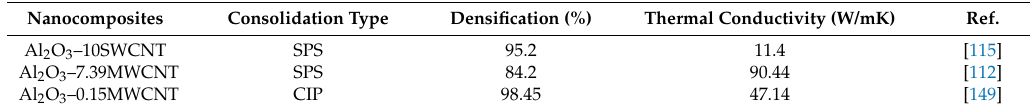
Table 4. Thermal conductivity of alumina–CNT